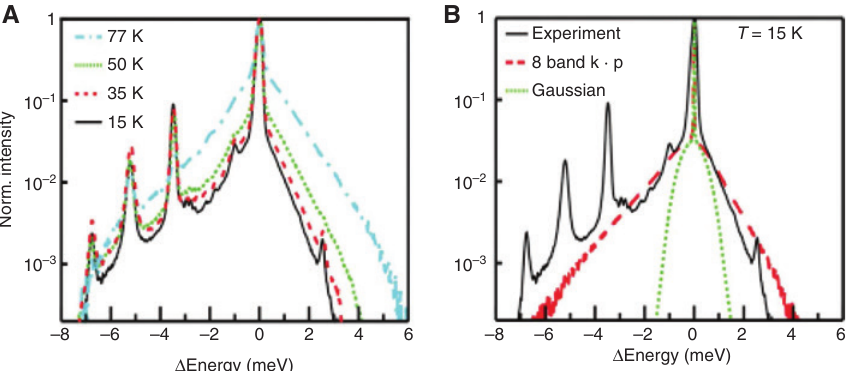
Figure 1: Semilogarithmic plot of the electroluminescence intensity of a single QD. (A) With increasing temperature the line broadening increases due to stronger acoustic phonon interaction. (B) Comparison of the measured lineshape with two calculated spectra, using alternatively a simple Gaussian (green dotted curve) or a realistic 8 band k · p wave function (red dashed curve). Reprinted figure with permission from [43]. © 2011 by the American Physical